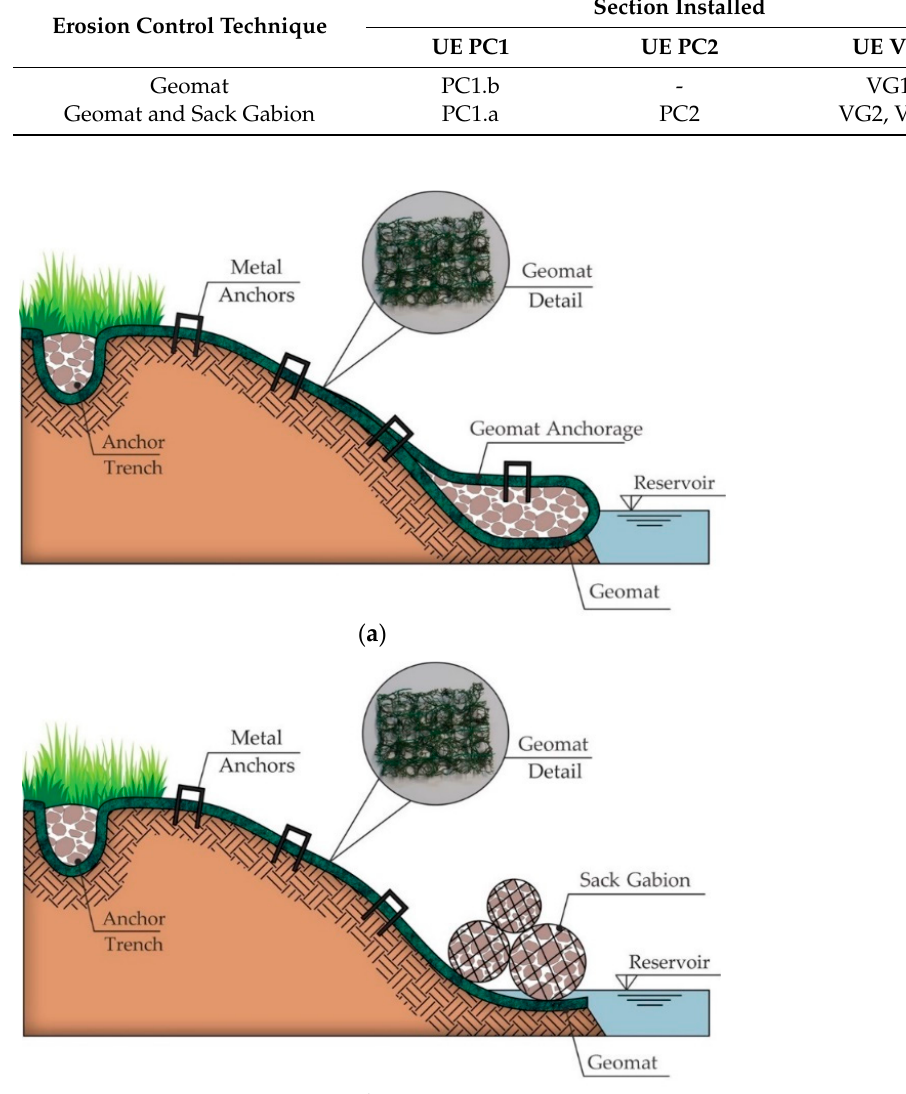
Figure 5. Geomat used in the erosion control techniques. Table 3. Geomat properties. Properties